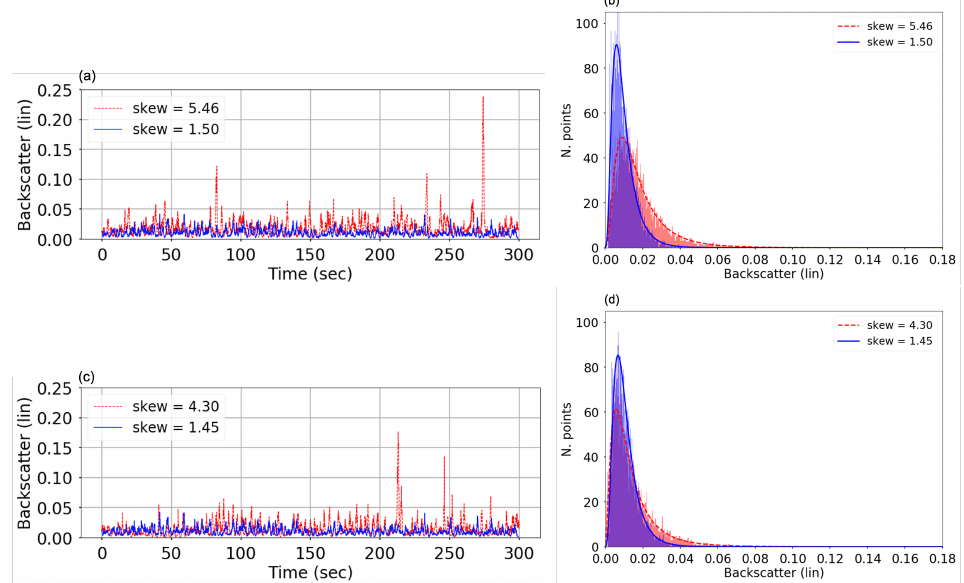
Figure 11. KaBODS backscatter time series (left) with the corresponding distributions in linear space (right). Data without large spikes are shown in blue, whereas the data corresponding to possible breaking events are shown in red. Data corresponding to two different wind speed conditions are con- sidered: 8–9 m/s ( a , b ) and 6–7 m/s ( c , d ), both in the upwind direction. ( a , b ) Data from 2019.10.23T03 (blue) and 2019.12.14T01 (red). ( c , d ) Data from 2019.11.15T13 (blue) and on 2019.12.22T15